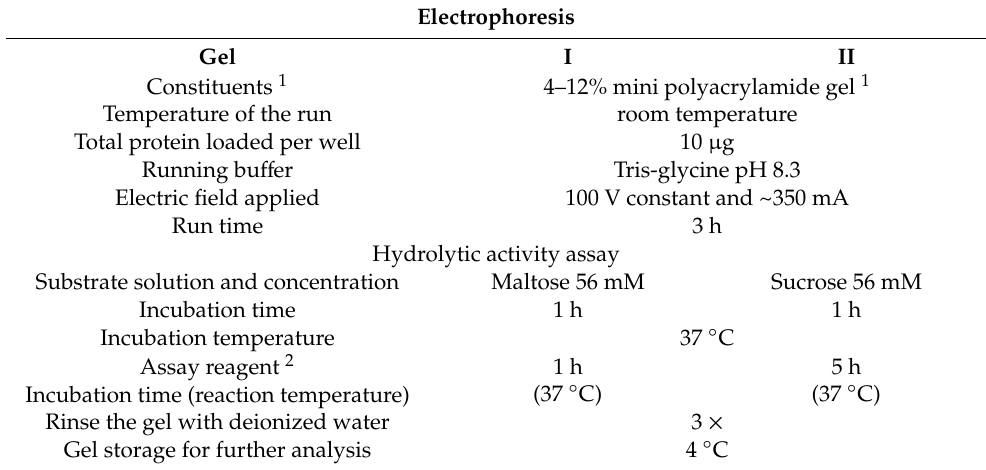
Table 1. Summary of parameters used with each substrate tested in the